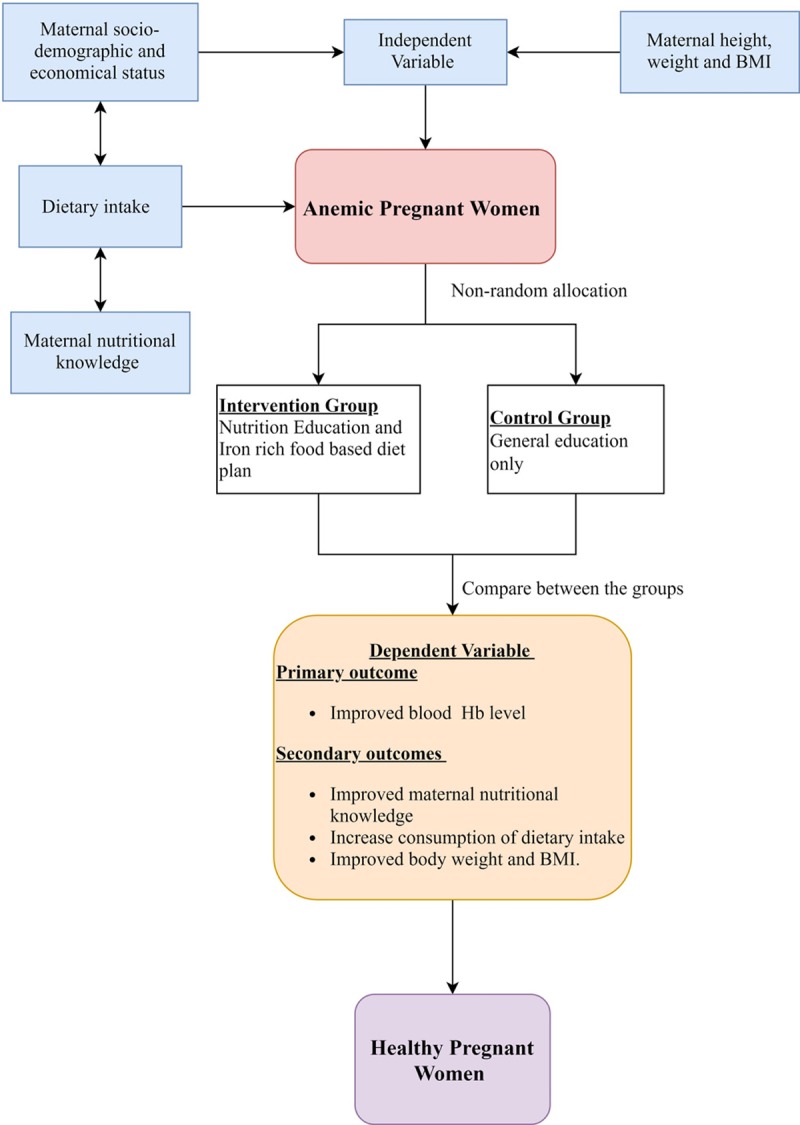
Conceptual framework of the study.